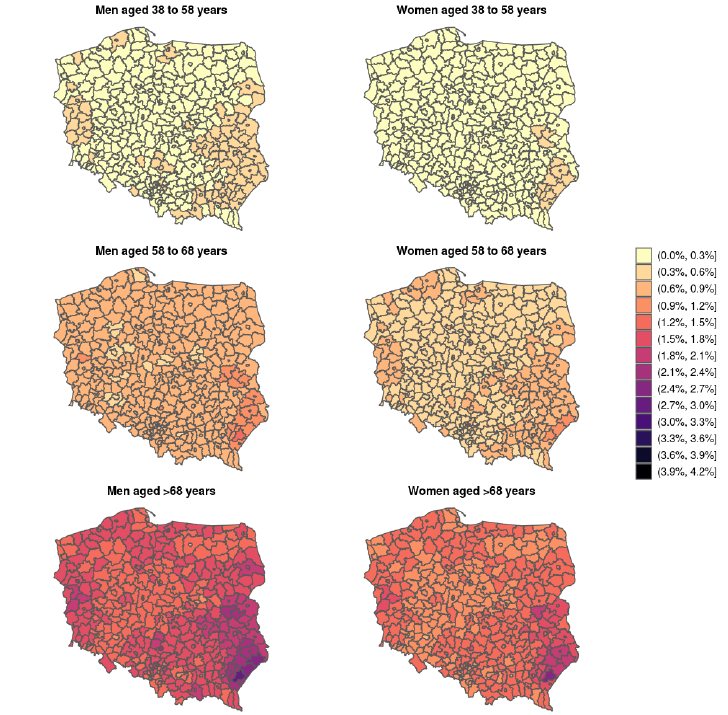
Figure 2. Estimated probability of stroke by gender and age group based on the LOGIT SPATIAL model.